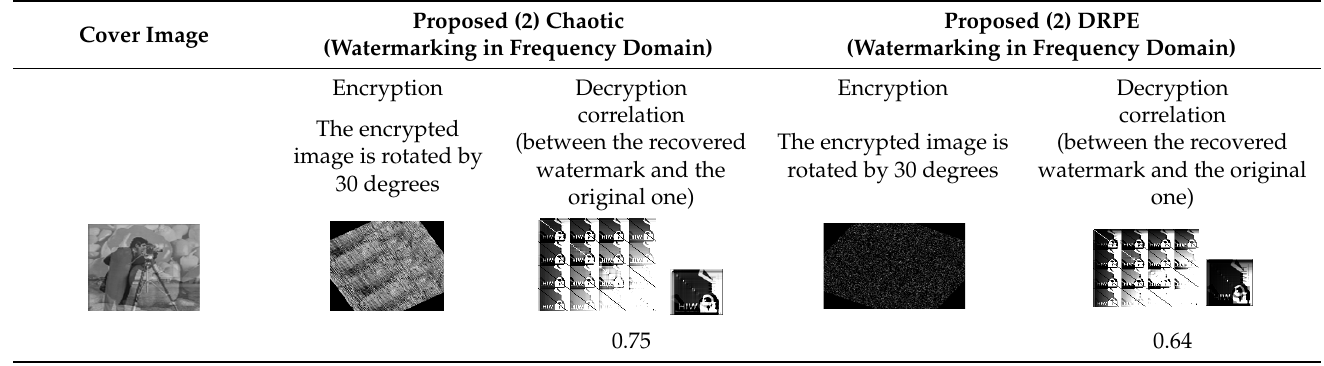
Table 9. Rotated images and corresponding extracted watermarks for the second proposed